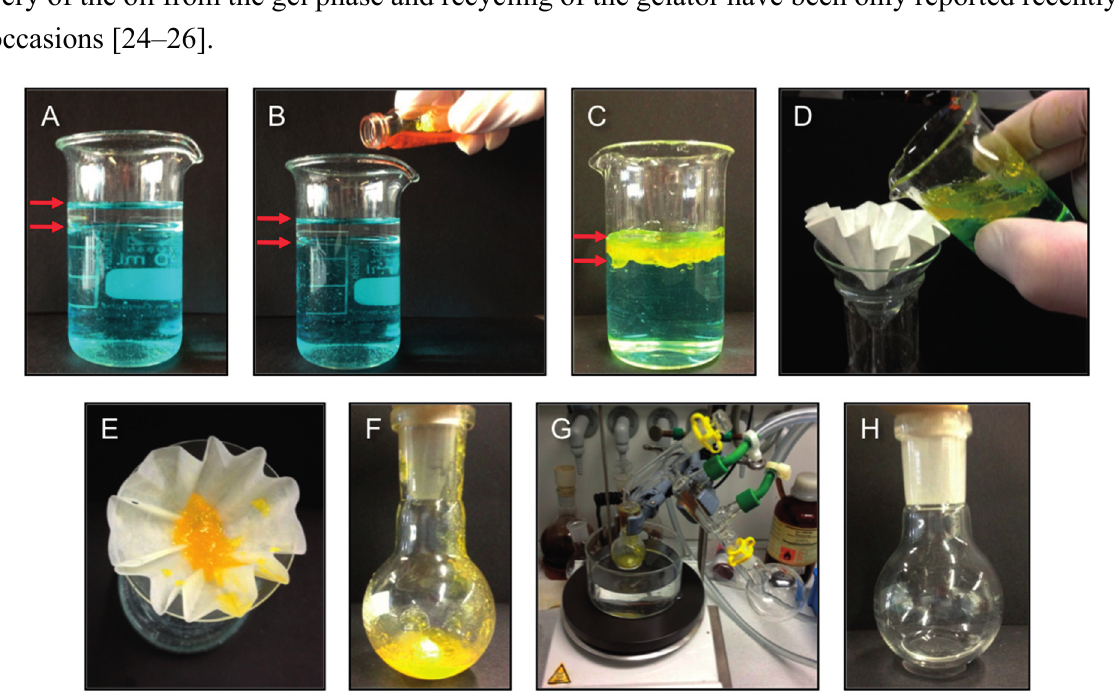
Figure 7. Model lab bench set up for oil spill recovery using the PSG ability of azobenzene-containing peptide A4 (2.0% w / v with respect to the volume of the oil-phase). ( A ) Mixture of salty water (NaCl 3.3% w / v , 40 mL) and toluene (5 mL). The aqueous layer was stained with CuSO 4 (Figure 7A) for better visualization of the two-phases indicated by red arrows; ( B ) Addition ultrasound-aided concentrated solution of gelator A4 (27.5% w / v ) in a small volume of toluene (0.4 mL); ( C ) Formation of a yellowish gel-phase containing the toluene layer; ( D , E ) Separation of the gel-phase by filtration; ( F , G ) Distillation of the gel-phase to recover both the yellowish gelator and the oil phase; and ( H ) Isolated